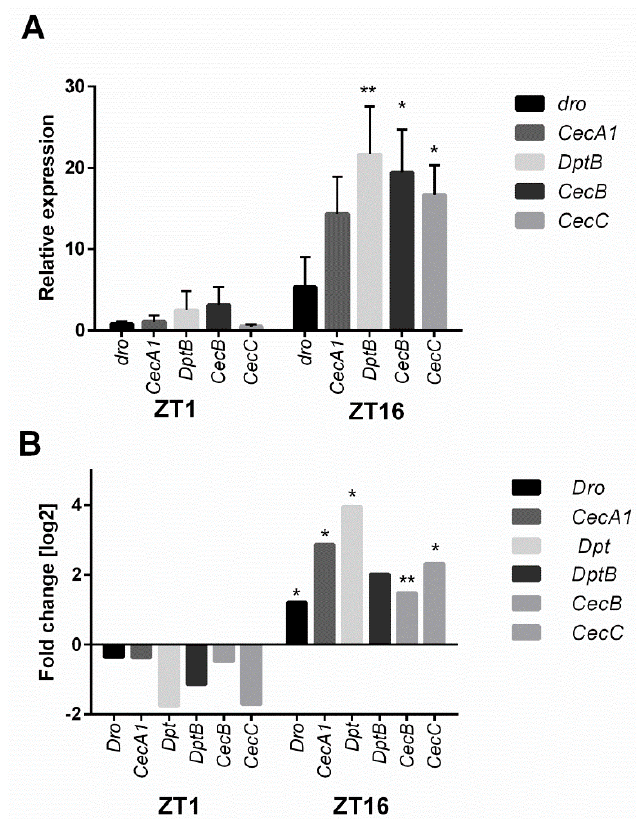
Figure 5. The comparison of microarray and qPCR data between GMR> hoRNAi and GMR> Valium10 flies of humoral immune response gene expression levels. ( A ) qPCR data are shown as a relative quantitation normalized to the control (GMR> Valium10 ) as value 1. Statistically significant differences are marked with asterisks: * p ≤ 0.05, ** p ≤ 0.005; ( B ) in microarray, fold change is relative to the control. Statistically significant differences are marked with asterisks: * 0.005 < p -values < 0.05, ** 0.0005 < p -values < 0.005. The following genes were examined: dro, CecA1, DptB, CecB, and CecC.